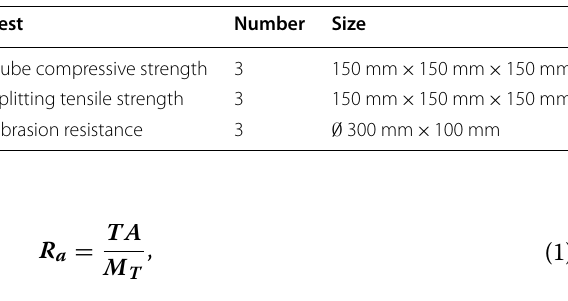
Table 4 Specimen number and size for each